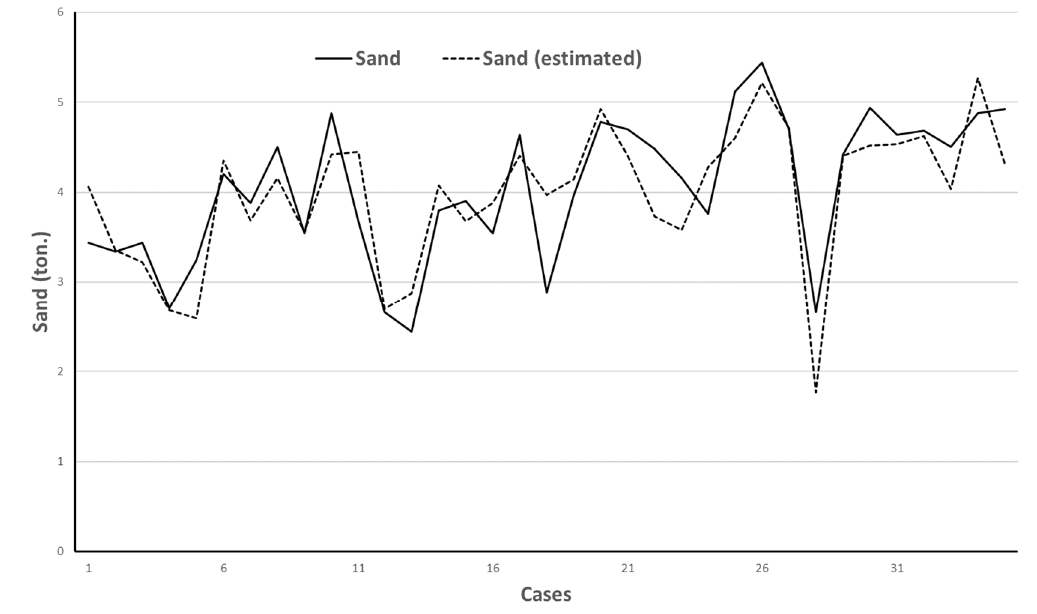
Figure 4. Prediction performance of MARS model (validation data).